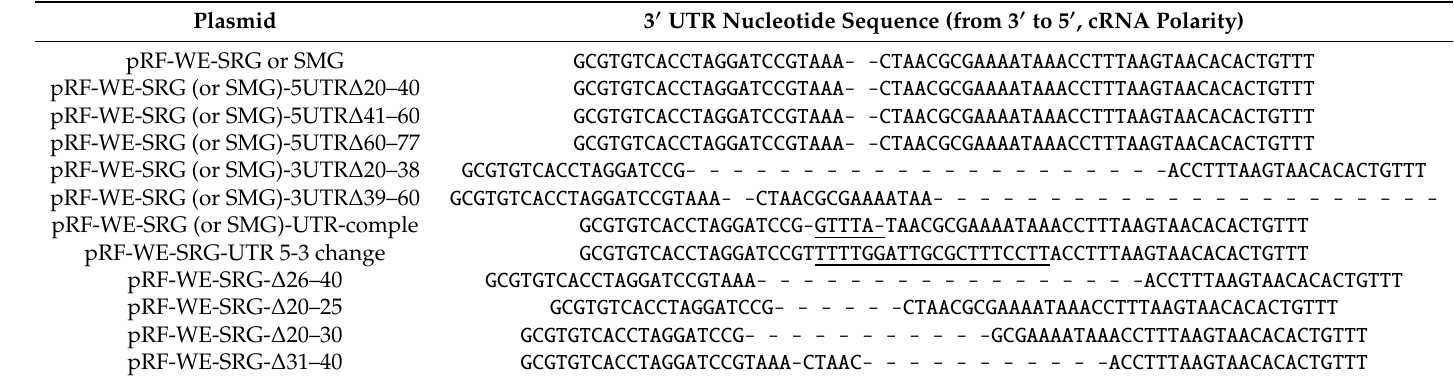
Table 2. The 3 (cid:48) nucleotide sequences of UTRs of plasmids for the reverse genetics and minigenome systems. Plasmid 3 (cid:48) UTR Nucleotide Sequence (from 3 (cid:48) to 5 (cid:48) , cRNA